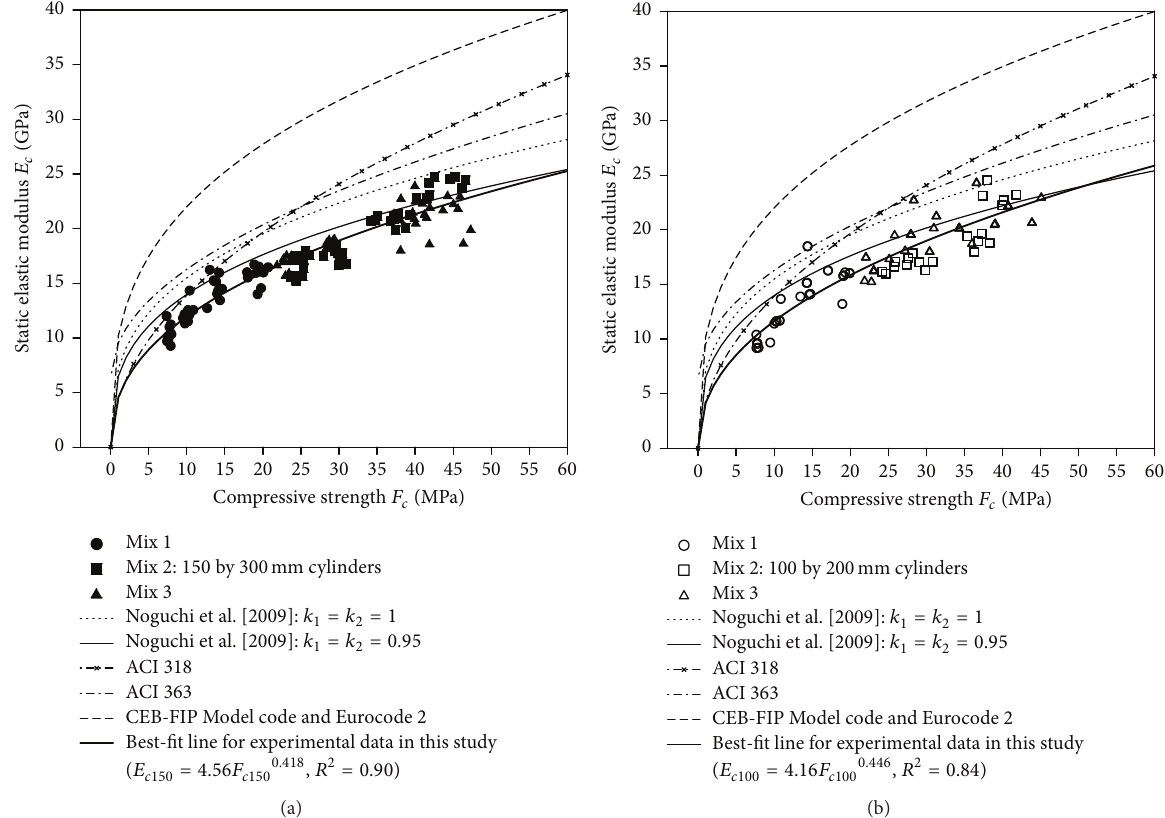
Figure 7: Comparison of compressive strength and static elastic modulus of concrete.